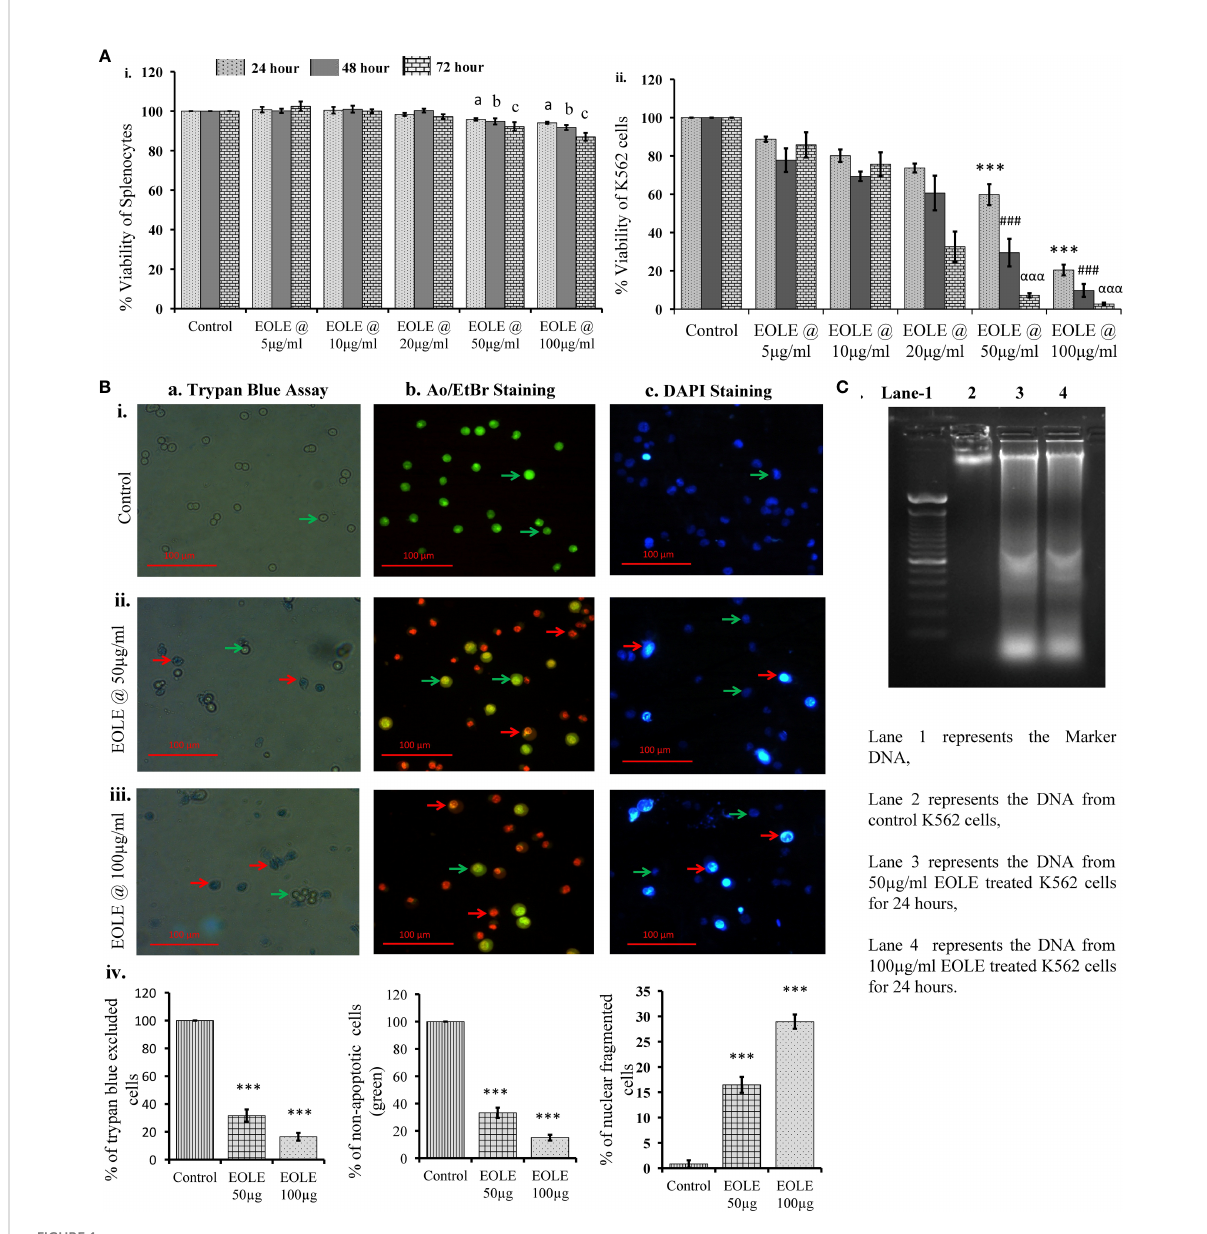
FIGURE 1 Figures showing the cytotoxic activity of EOLE: (A) Viability percentage of control and EOLE-treated K562 and splenocytes evaluated through MTT assay, where (i) Viability of mouse splenocytes, (ii) Viability of K562 cells; values are expressed as mean ± SD of 3 observations. The statistical signi fi cance was tested using one-way ANOVA following Tukey ’ s multiple comparison tests by comparing the values as, control vs . treatments separately for 24 hours, 48 hours, and 72 hours. P value, p < 0.05 was considered as statistically signi fi cant. When compared between control vs . treatment for 24 hours the level of signi fi cance is denoted as, a = not signi fi cant when p > 0.05; * when p < 0.05; ** when p < 0.01; and *** when p < 0.001. When compared between control vs . treatment for 48 hours the level of signi fi cance is denoted as, b = not signi fi cant when p > 0.05; # when p < 0.05; ## when p < 0.01; and ### when p < 0.001. When compared between control vs . treatment for 72 hours the level of signi fi cance is denoted as, c = not signi fi cant when p > 0.05; a when p < 0.05; aa when p < 0.01; and aaa when p < 0.001; (B) Result of the trypan blue dye exclusion assay, AO/EtBr staining, and DAPI staining, where (a) Trypan blue assay, (b) AO/EtBr staining, (c) DAPI staining: (i) Representative images of control group, (ii) Representative images of EOLE-treated (50 µg/ml) group, (iii) Representative images of EOLE-treated (100 µg/ml) group, (iv) Bar diagrams showing results of staining assay. Values are expressed as mean ± SD of 3 different observations. The statistical signi fi cance was tested using one-way ANOVA followed by Tukey ’ s multiple comparison tests by comparing the values as, control vs . treatments. P-value, p < 0.05 was considered as statistically signi fi cant and denoted as, a = not signi fi cant when p > 0.05; * when p < 0.05; ** when p < 0.01; and *** when p < 0.001; (C) The representative image of the DNA ladder